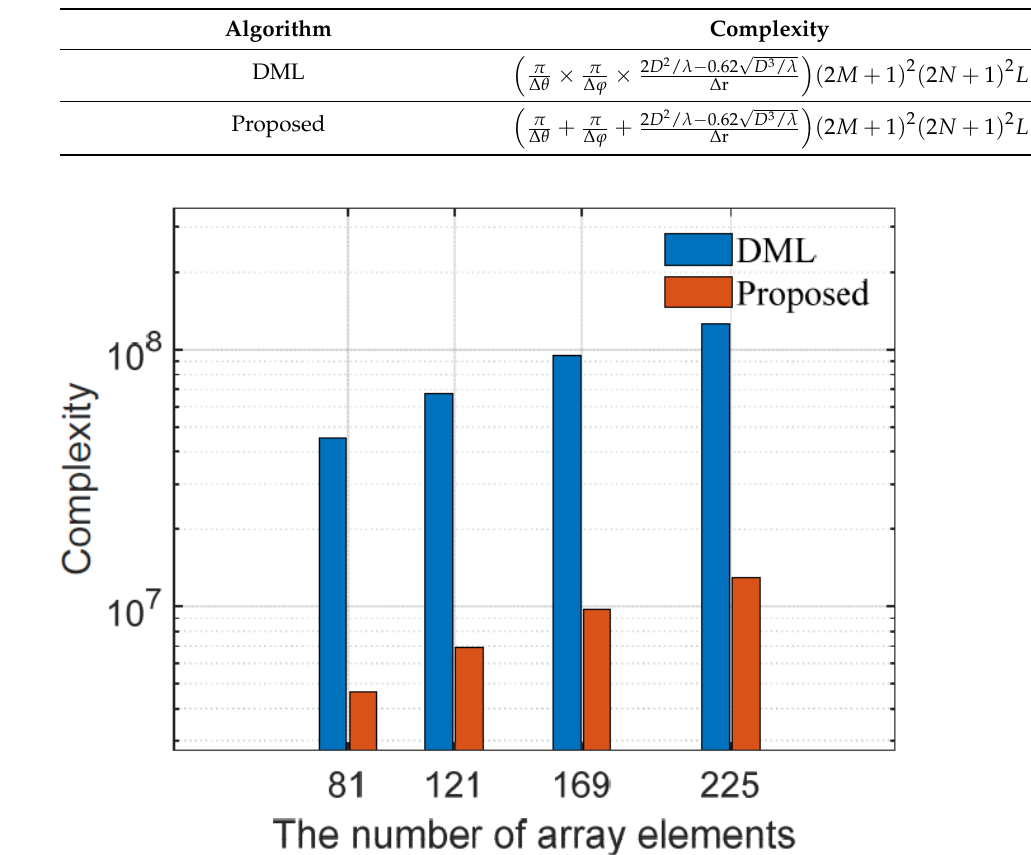
Figure 8. Complexity comparison of two algorithms.